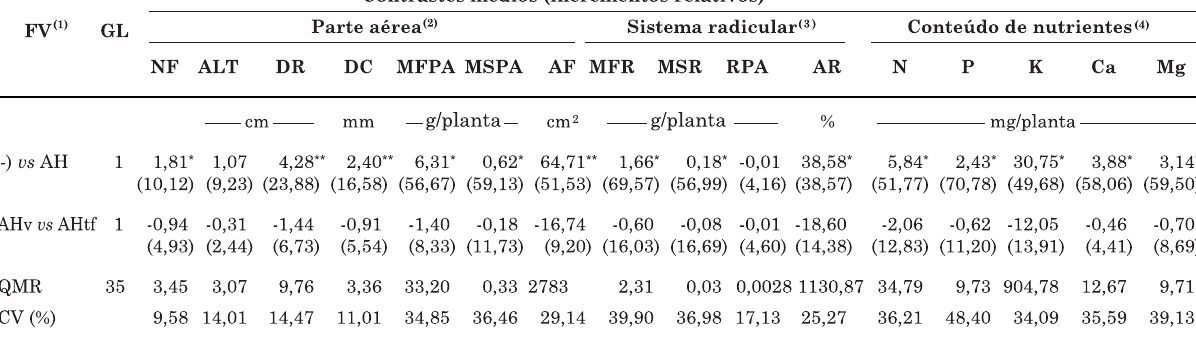
Com relação aos teores dos pigmentos fotossintéticos, incluindo clorofila a , clorofila b e carotenoides, em média pouco variaram entre os tratamentos (Quadro 4), não apresentando contrastes significativos (Quadro 5). Entretanto, foi detectado aumento significativo na relação entre clorofila a